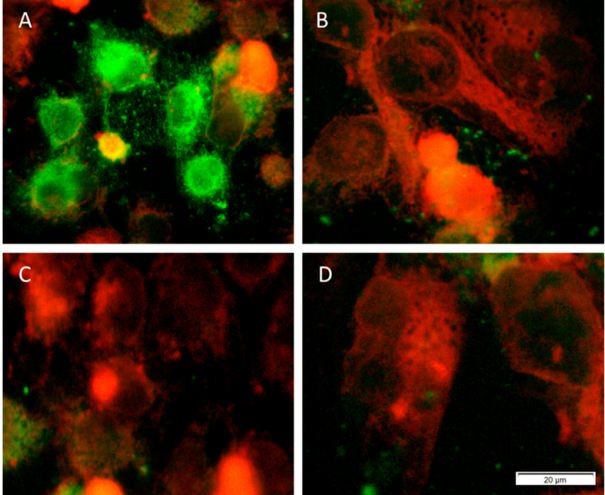
Figure 2. Immunofluorescence-stained inclusions of C. trachomatis D in HeLa cells. The cells were infected with ( A ) C. trachomatis D alone or with C. trachomatis D pre-incubated with ( B ) thymoquinone; ( C ) carvacrol; ( D ) thymol at a concentration of 50 µ M. Pictures were acquired by a digital camera attached to a fluorescence